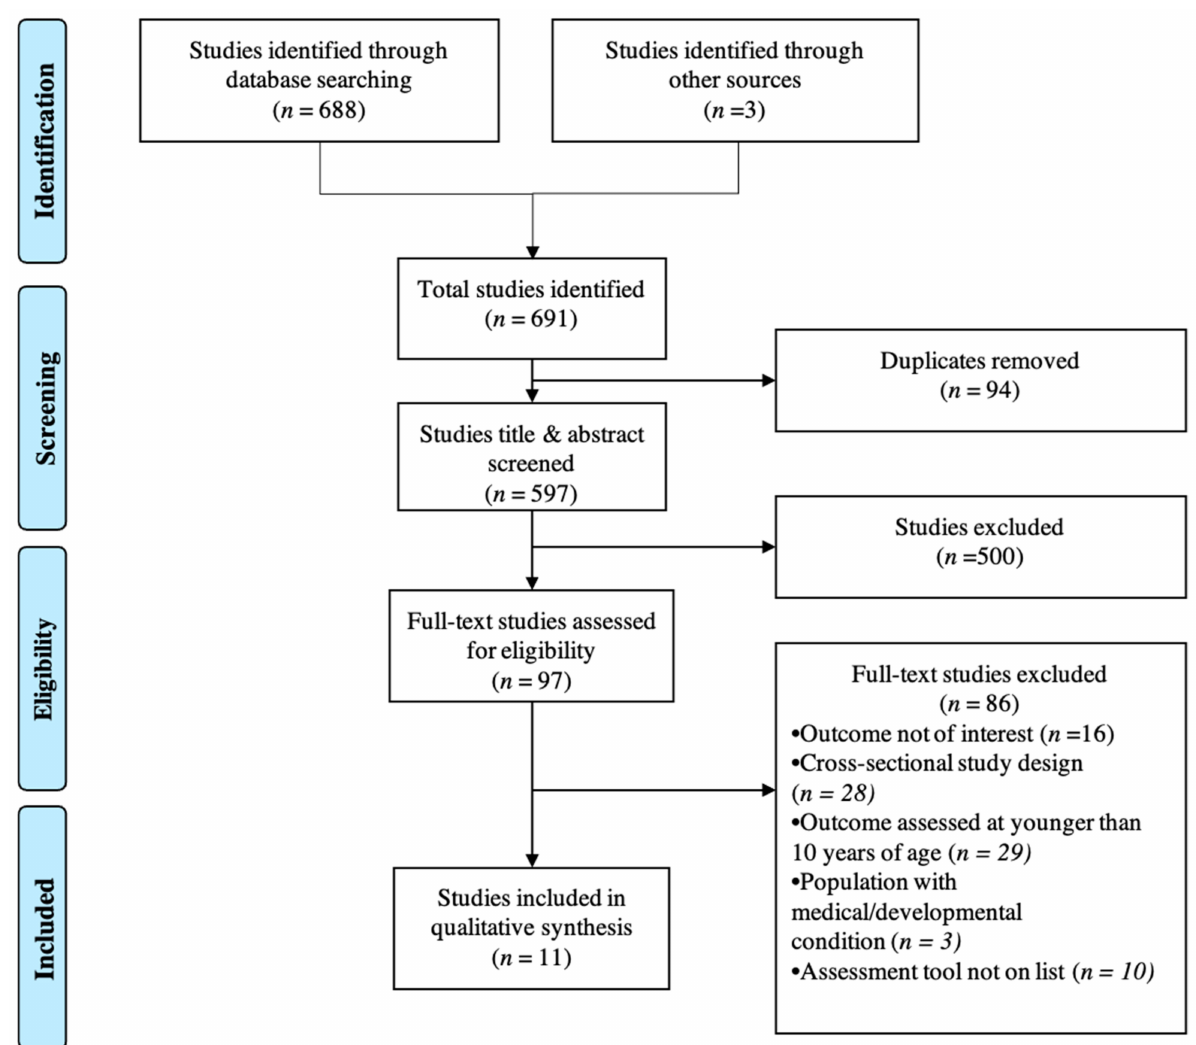
Figure 1. A Preferred Reporting Items for Systematic Reviews and Meta-Analyses (PRISMA) flowchart of the selection process of published